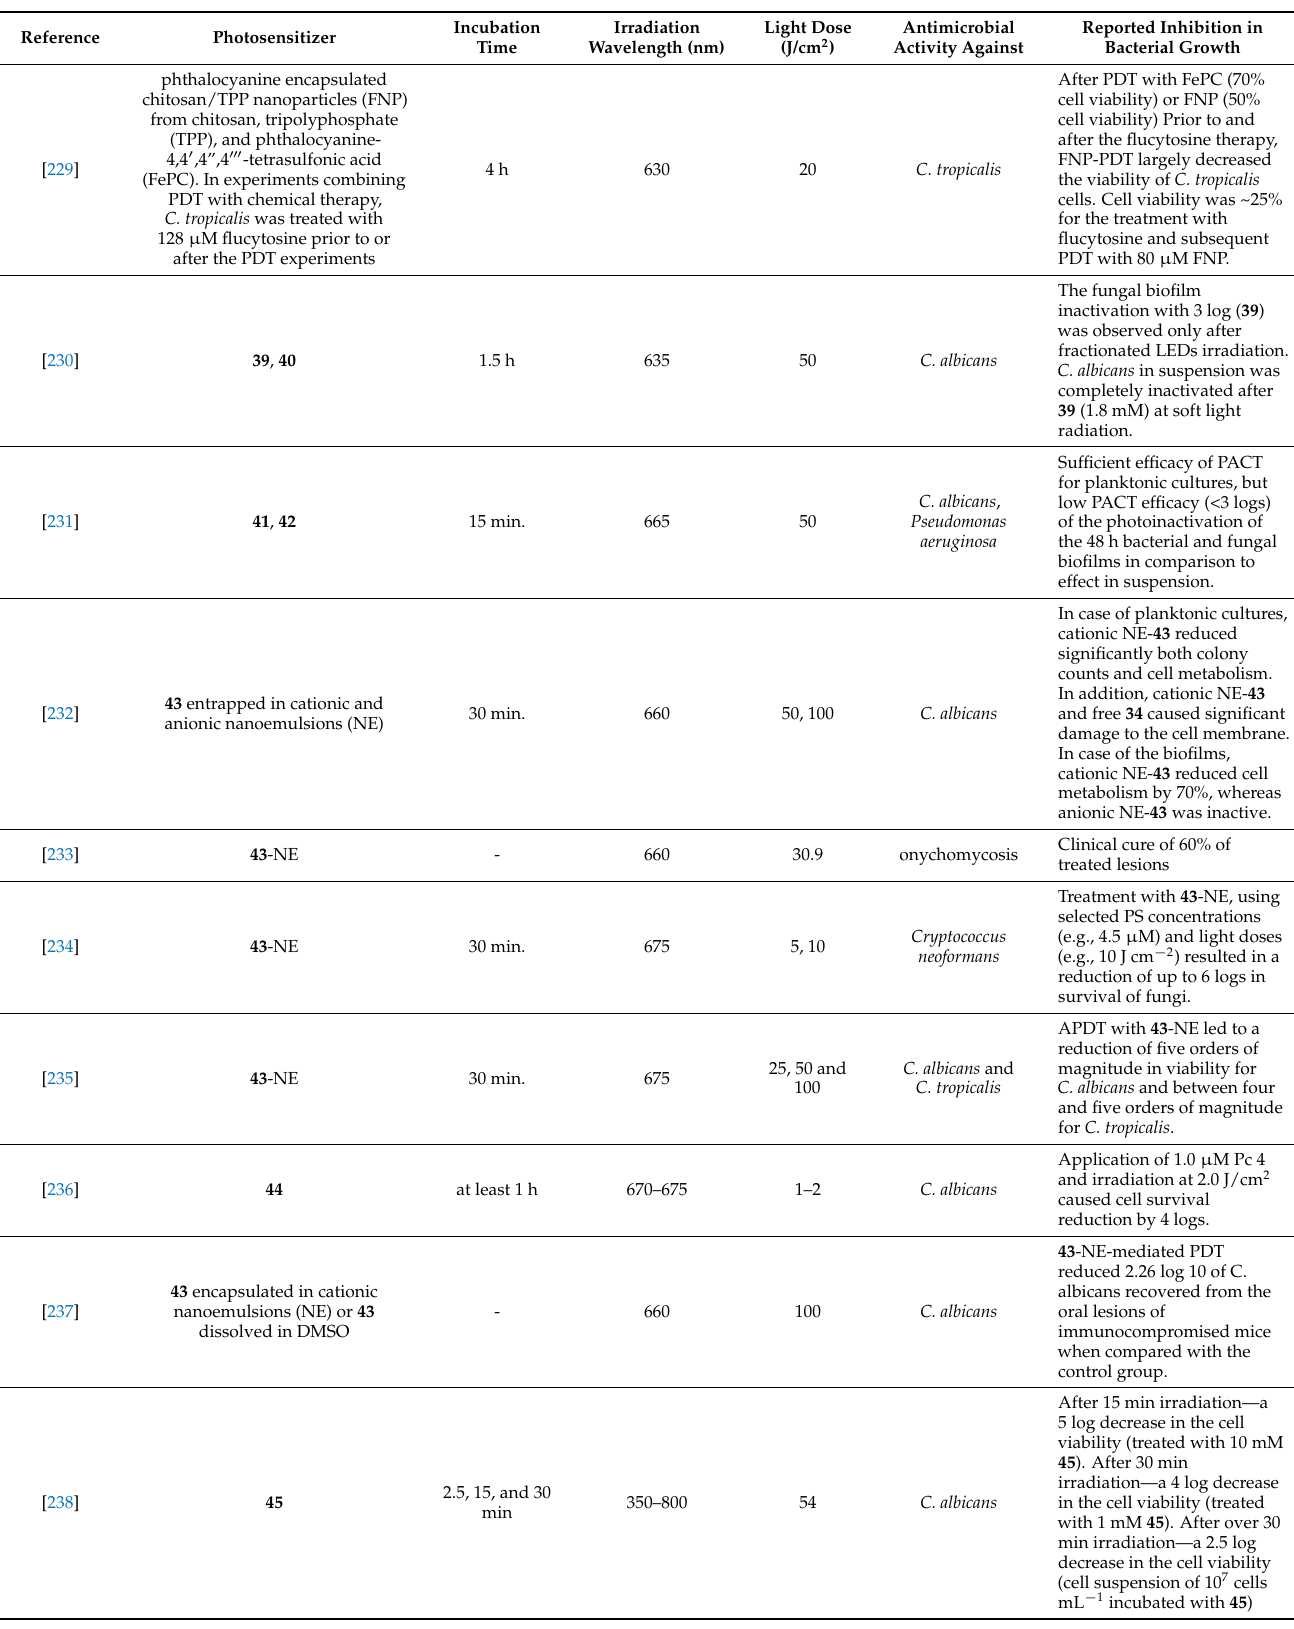
Table 6. Porphyrazines and phthalocyanines—photodynamic antimicrobial activity and